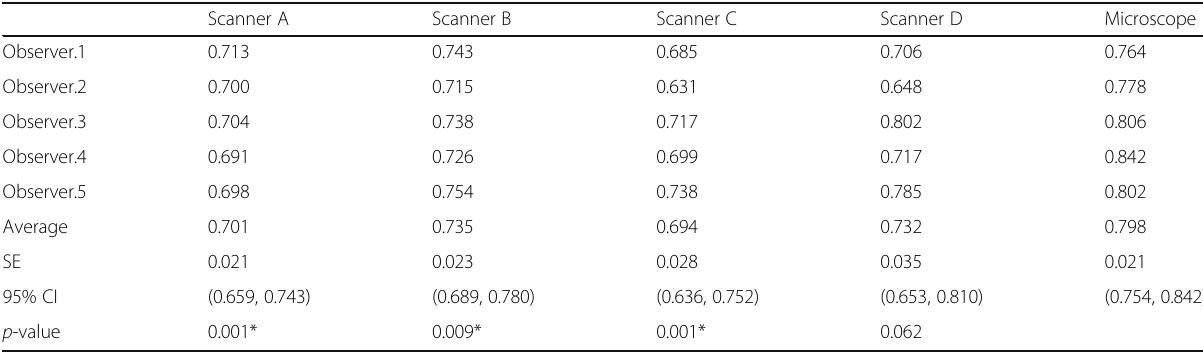
Table 4 Accuracy for all readers and observation methods Scanner A Scanner B Scanner C Scanner D Microscope